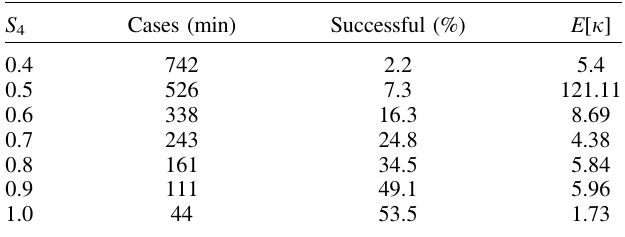
Table 1. Total of cases available and the percentage of cases where j was successfully estimated.